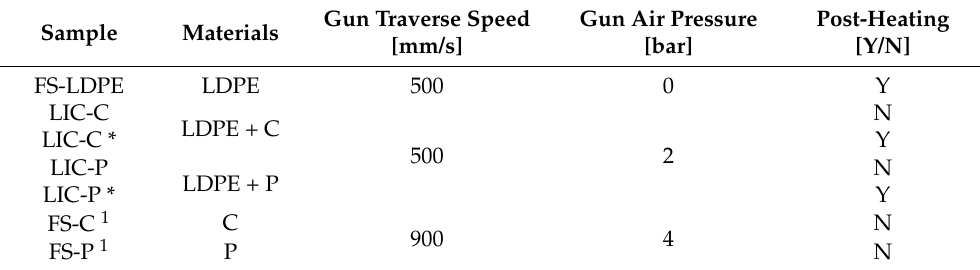
Table 2. List of lubricated icephobic coatings (LICs) and flame-sprayed (FS) feedstock material coatings with details on employed materials and process parameters. LDPE, C, and P refer to low- density polyethylene, fully hydrogenated cottonseed oil, and paraffinic wax powders, respectively.